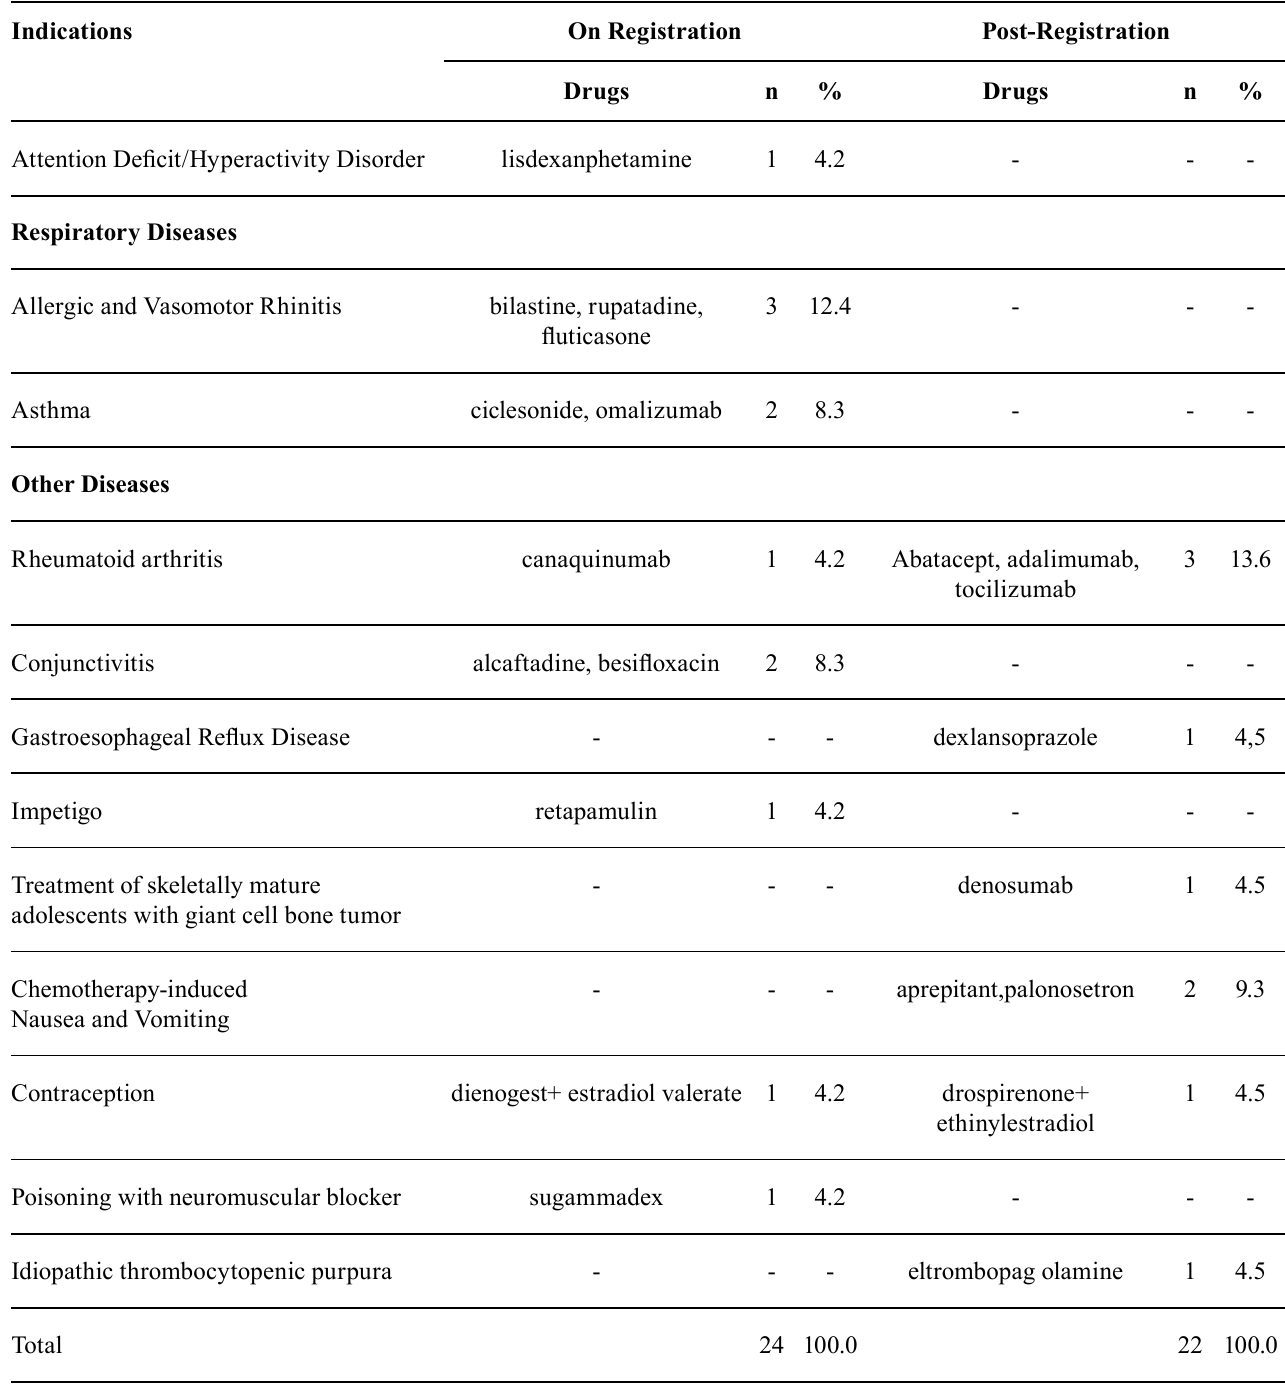
TABLE II – Indication of the 46 medicines with pediatric indication identified in the cohort of new drugs registered from 2003 to